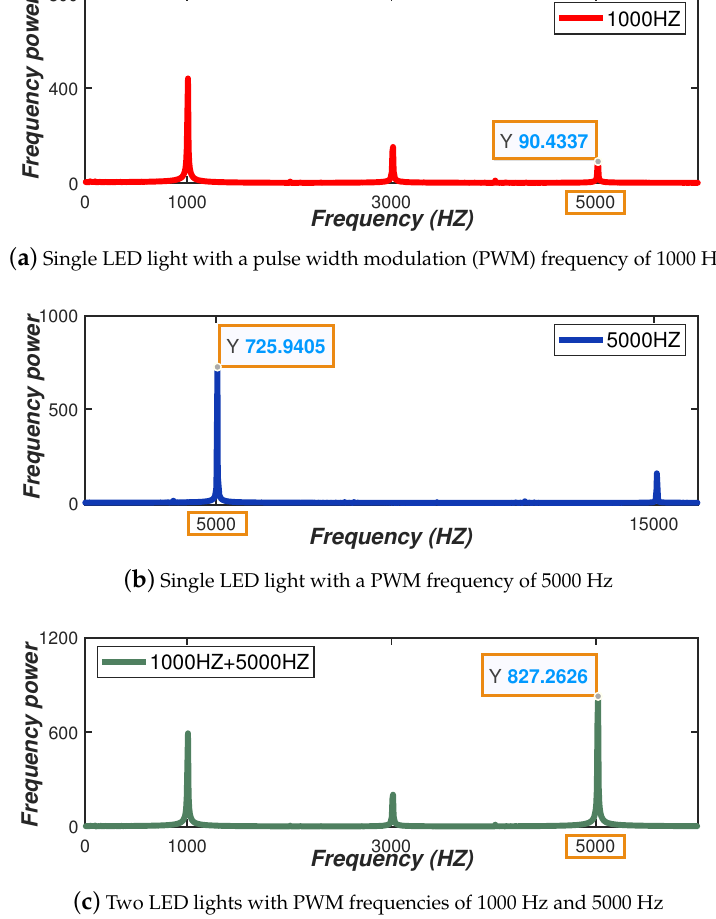
Figure 5. The effect of frequency multiple and corresponding frequency